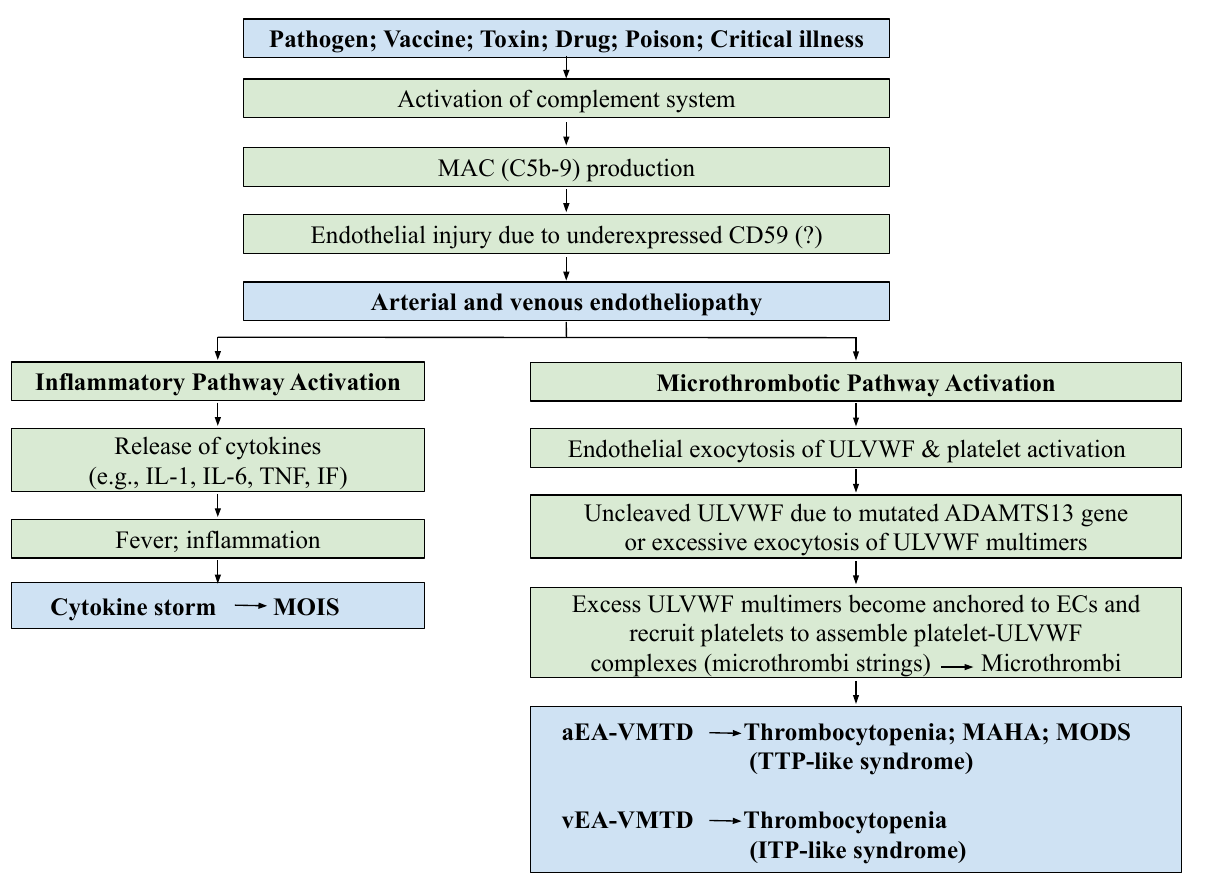
Figure 1 . Pathogenesis of endotheliopathy based on “two-activation theory of the endothelium”. Endothelial molecular pathogenesis is initiated by the activated complement system following ex- posure to a pathogen, toxin, drug, poison, venom, vaccine, polytrauma, hyperglycemia, severe hy- pertension, and others. Endotheliopathy releases inflammatory cytokines and hemostatic factors, and activates two clinically important pathways: inflammatory and microthrombotic. Both arterial endotheliopathy and venous endotheliopathy provoke inflammation via the inflammatory path- way, leading to inflammatory syndrome, such as MOIS due to cytokines, but arterial endotheliopa- thy promotes microthrombosis via the microthrombotic pathway and produces aEA-VMTD due to the activation of the ULVWF path of hemostasis. Arterial endotheliopathy is characterized by the triad of thrombocytopenia, MAHA, and MODS, which is called “TTP-like syndrome”, but venous